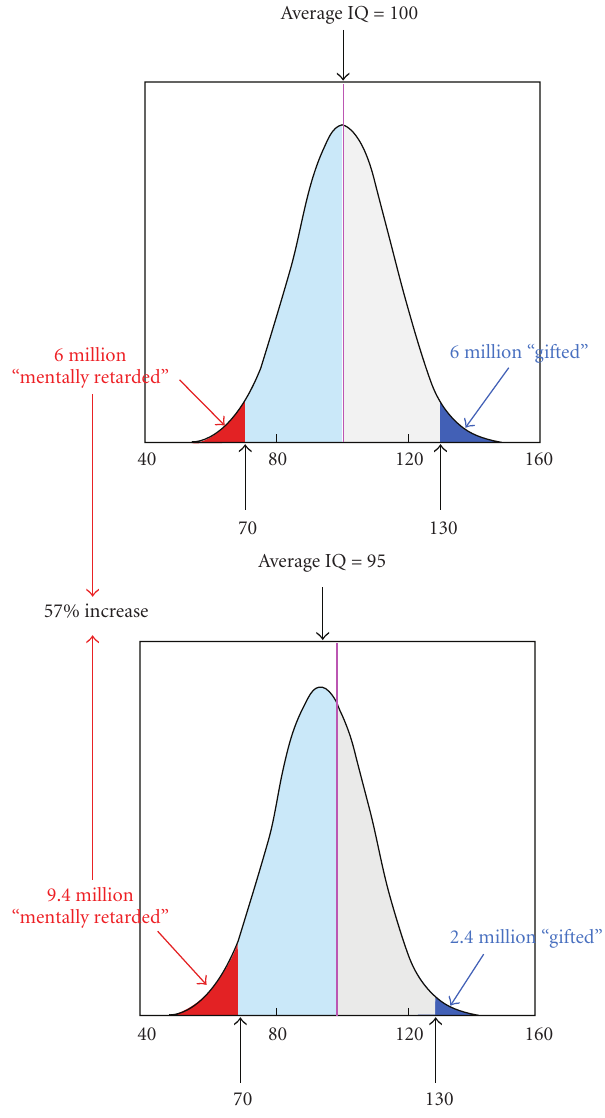
Figure 1: Showing the consequences of a shift in the population IQ of 5 points (5%) in a population of 100 million. In most US school districts, an IQ of 70 or lower (2 SDs below the mean) mandates remedial action. (Based on Weiss [3]).